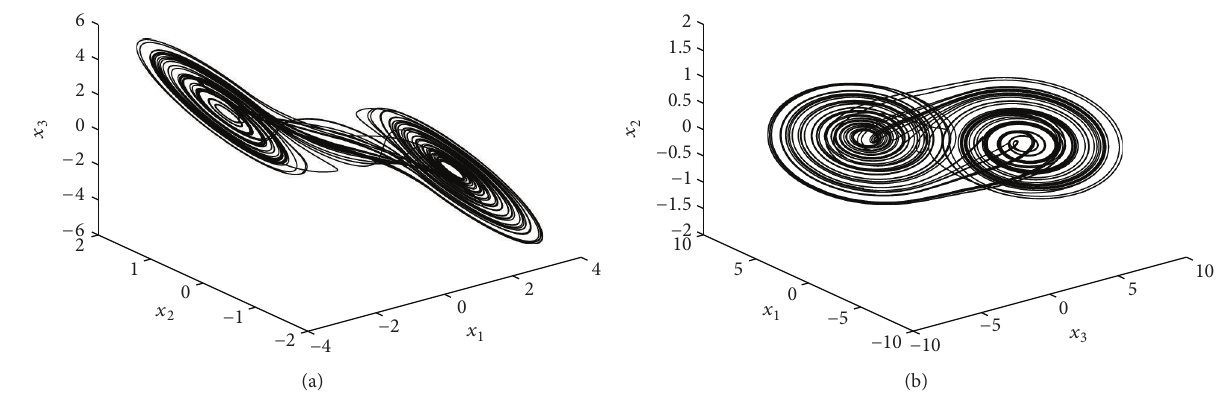
Figure 4: The attractors of CNN system (a) 𝑥 1 − 𝑥 2 − 𝑥 3 and (b) 𝑥 3 − 𝑥 1 − 𝑥 2 .